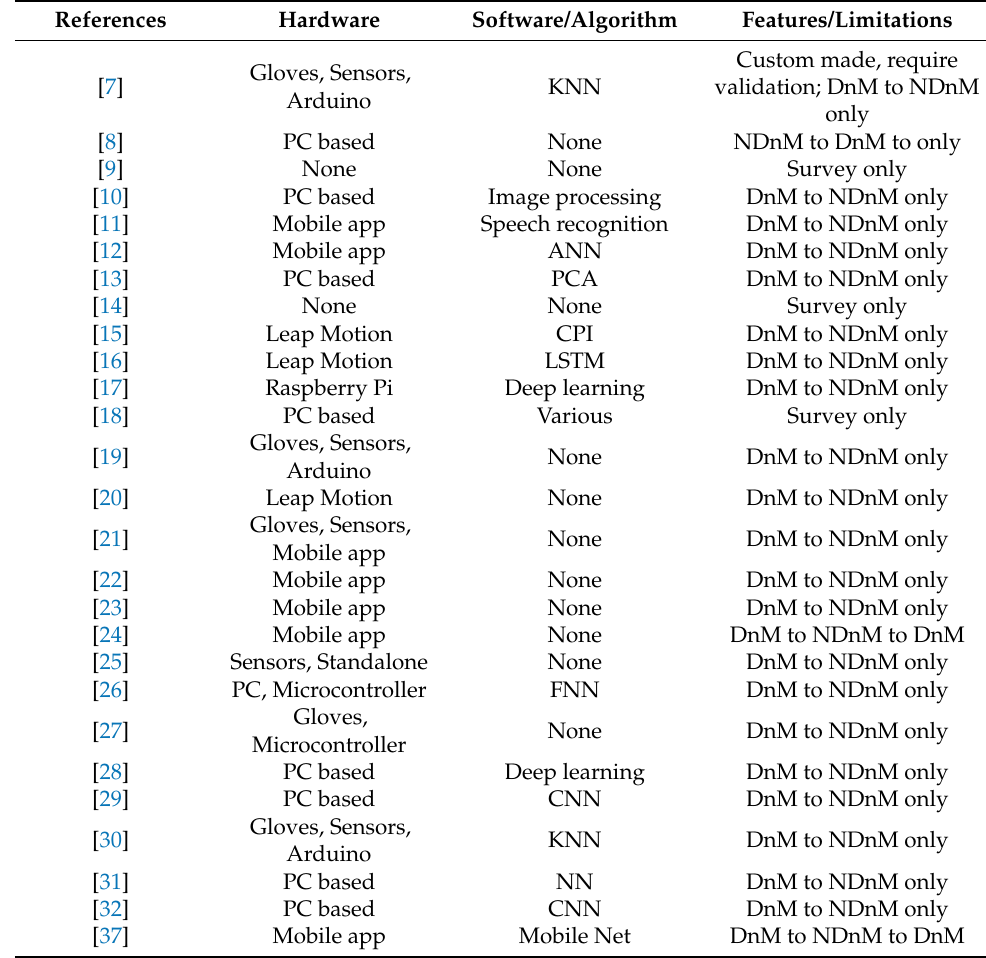
Table 1. Summary of literature